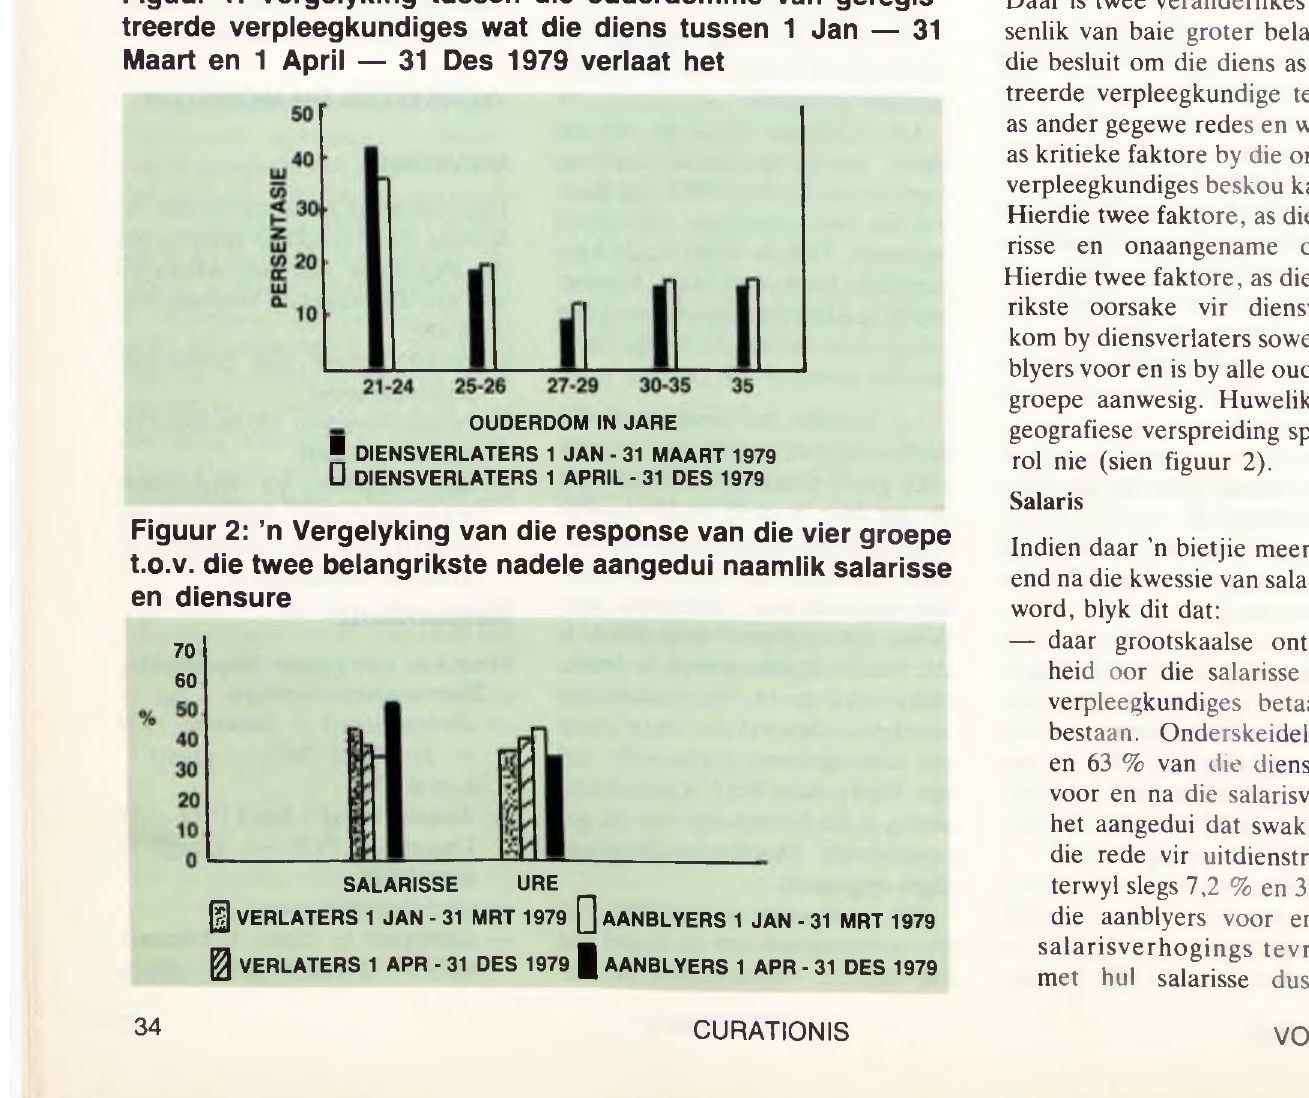
OUDERDOM IN JARE